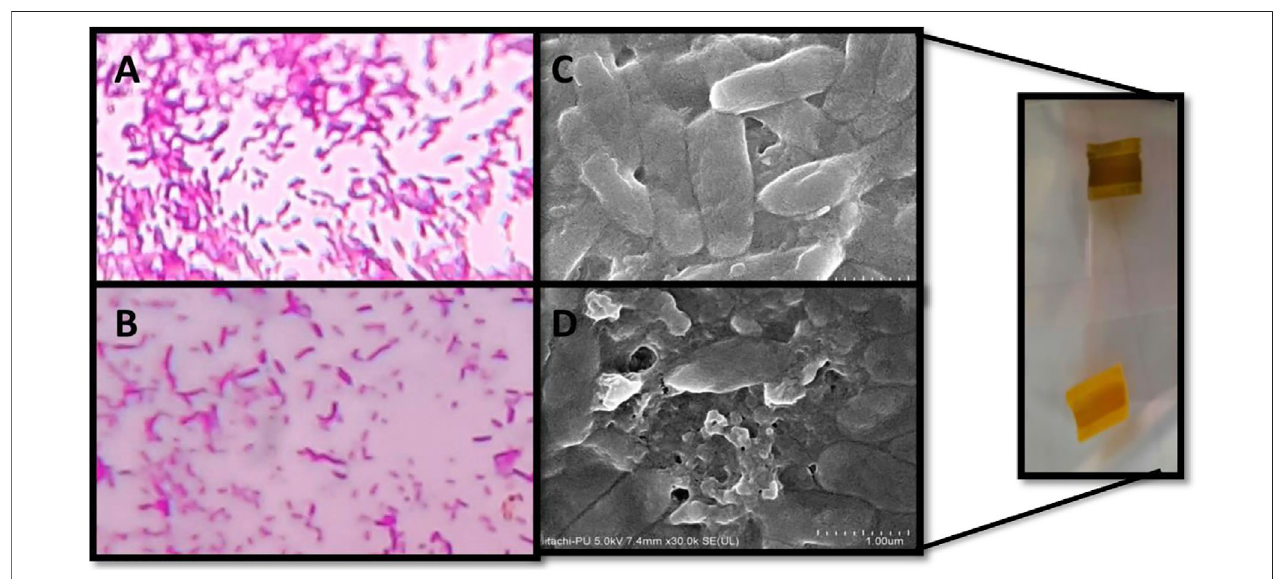
FIGURE 8 | Microscopic visualization of P. aeruginosa bio fi lms. Peak-day bio fi lm formed in the absence (A,C) and presence (B,D) of sub-MIC of catechol – zingerone conjugate 1 by light microscopy at ×100 (A,B) and scanning electron microscopy (C,D) .